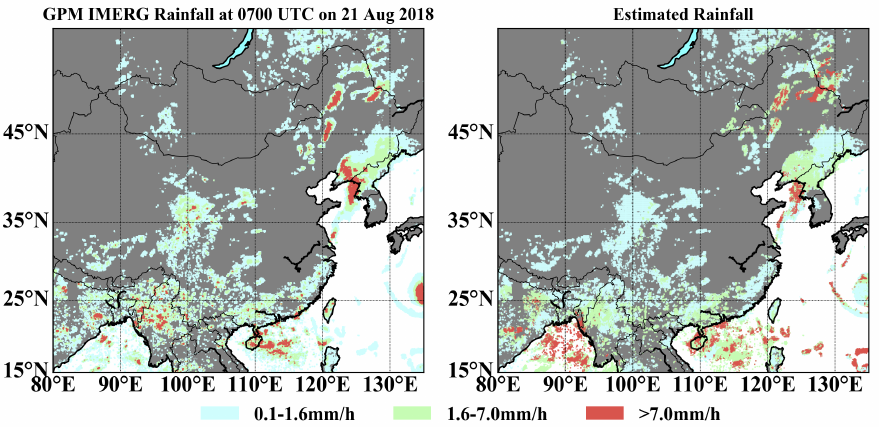
Figure 12. Comparisons of the precipitation grades’ estimation between the GPM ( left ) and RF model ( right ) on 0700 UTC 21 August 2018.